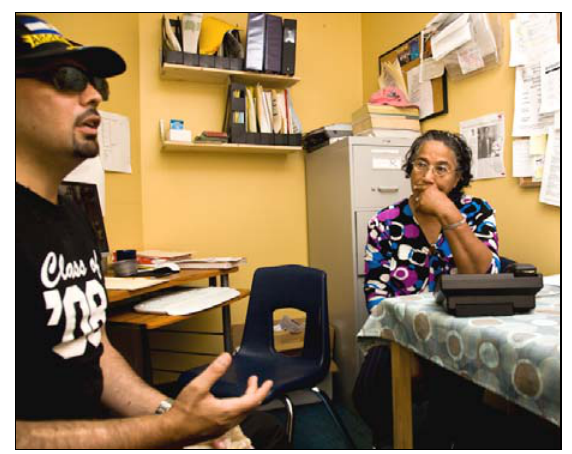
Figure 5: Community Action